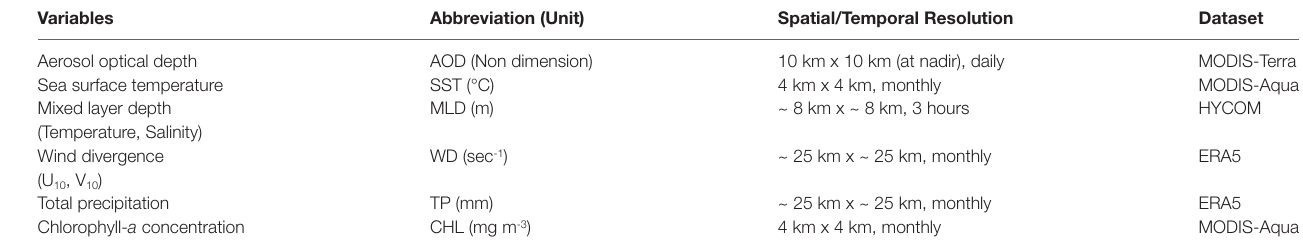
TABLE 1 | Description of the dataset of using satellite, reanalysis, and model data.